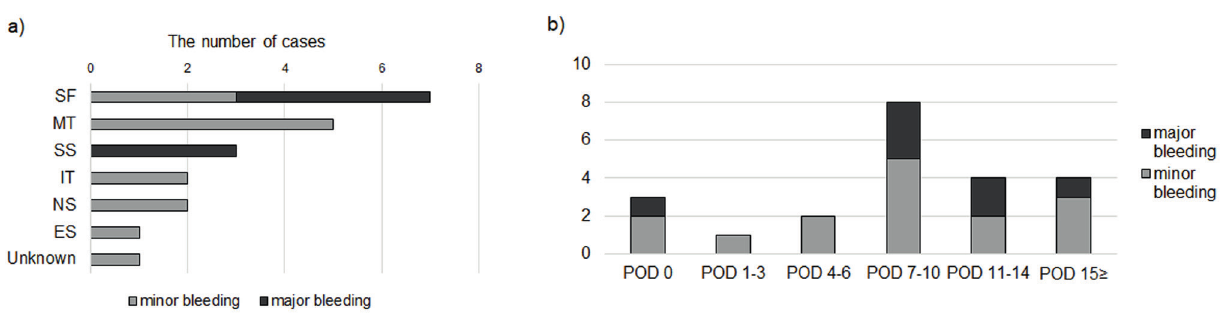
Figure 1. The site and timing of postoperative hemorrhage. a) The site of bleeding. b) The timing of postoperative haemorrhage. SF = sphenopalatine foramen; MT = middle turbinate; SS = anterior face of sphenoid sinus; IT = inferior turbinate; NS = nasal septum; ES = ethmoid sinus; POD = postop- erative